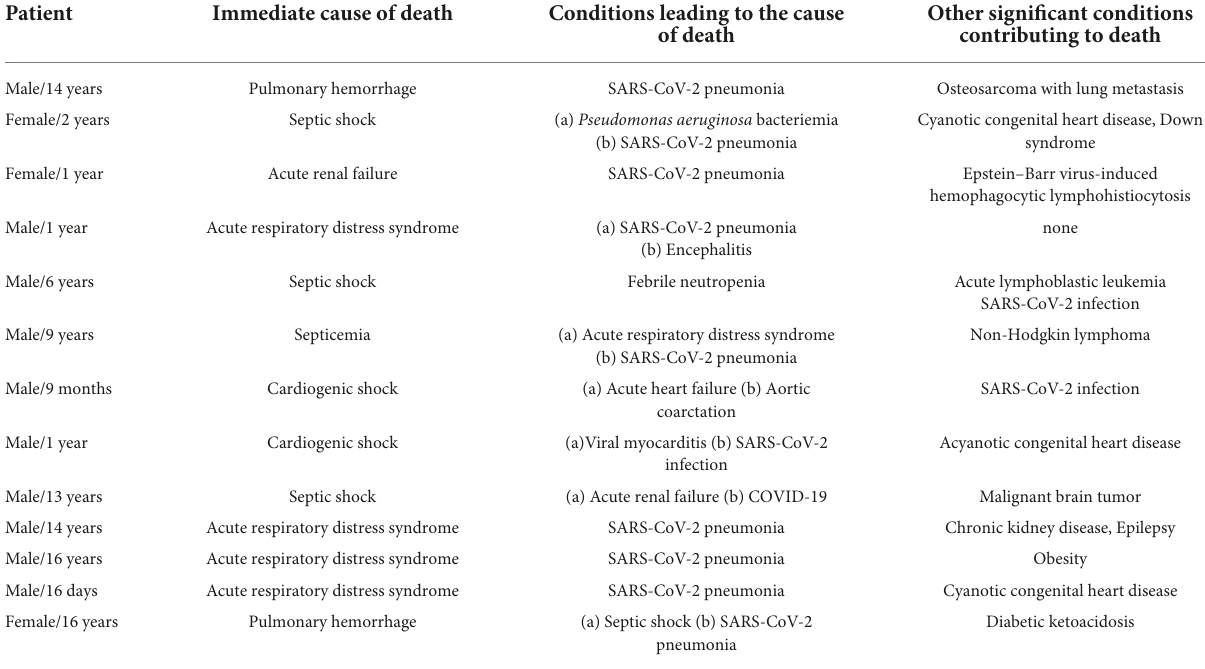
TABLE 6 Cause-of-death according to the official certificate in hospitalized patients with SARS-CoV-2 infection.